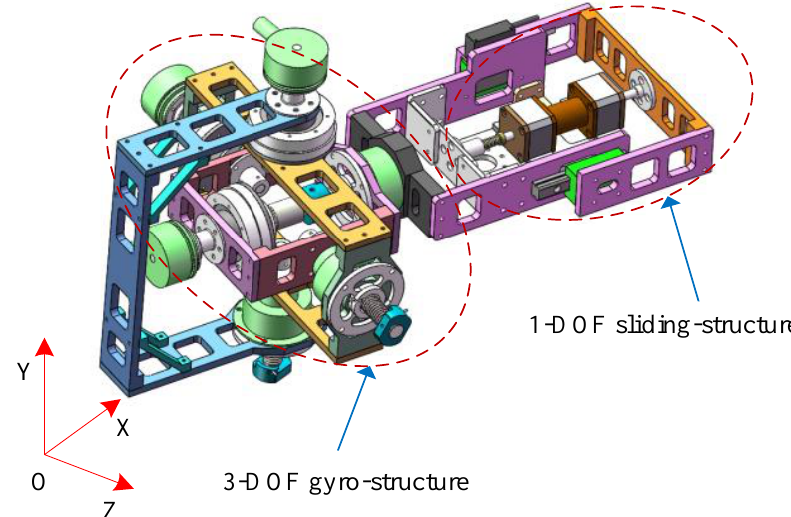
Figure 1. 3D model of the full-dimensional controllable damping mechanism with gyro-structure [20].